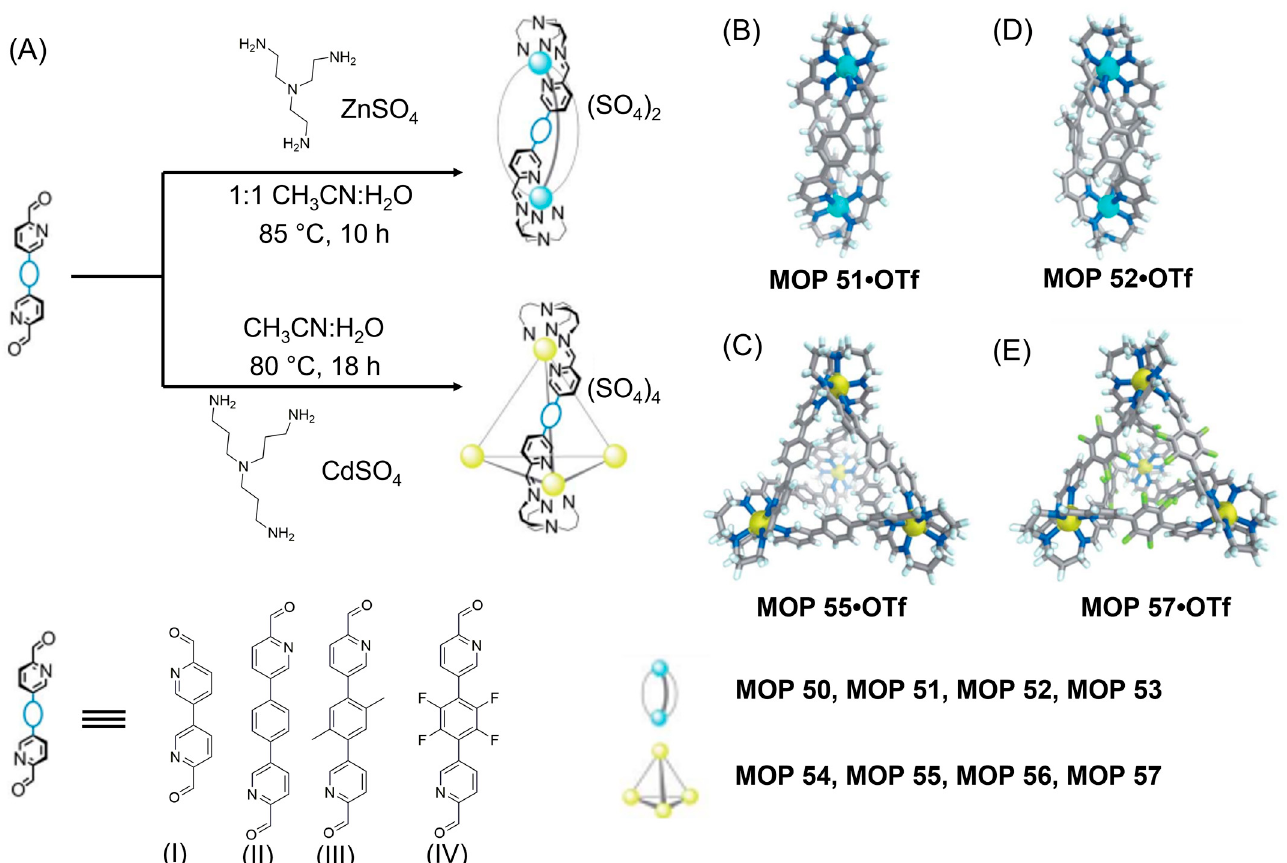
Figure 21. Water-soluble Zn II and Cd II -based architectures. ( A ) Self-assembly of Zn II -helicates and Cd II -tetrahedron from C 2 -symmetric subcomponents I–IV and the tritopic amines TREN and TRPN. Structures based upon bis-(pyridine aldehyde): cationic portions of the X-ray structures of ( B ) helicate Zn-MOP 51 • OTf and ( C ) tetrahedron Cd-MOP 55 • OTf. ( D ) Cationic parts of the X-ray structures of helicate Zn-MOP 52 • OTf (based upon aldehyde (III) and ( E ) tetrahedron Cd-MOP 57 • OTf (based upon aldehyde (IV). Counterions, solvents and disorder are omitted for clarity. Zn II , Cd II and fluorine atoms are coloured cyan, yellow, and pale green, respectively. Reprinted by permission from Ref. [174]. Copyright from 2019 from Royal Society of Chemistry.